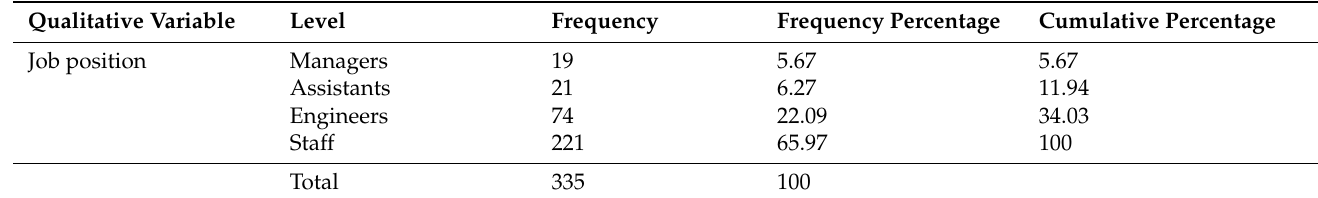
Table 31. Frequency distribution of job position in the